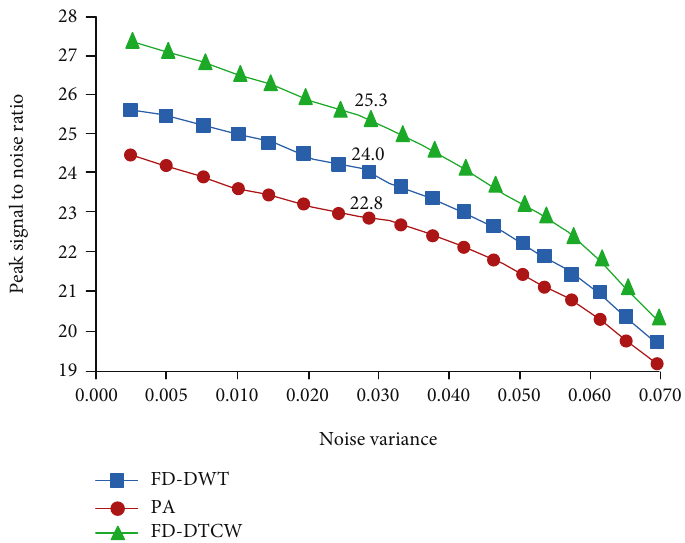
Figure 9: The variation of peak signal-to-noise ratio of each model on the test